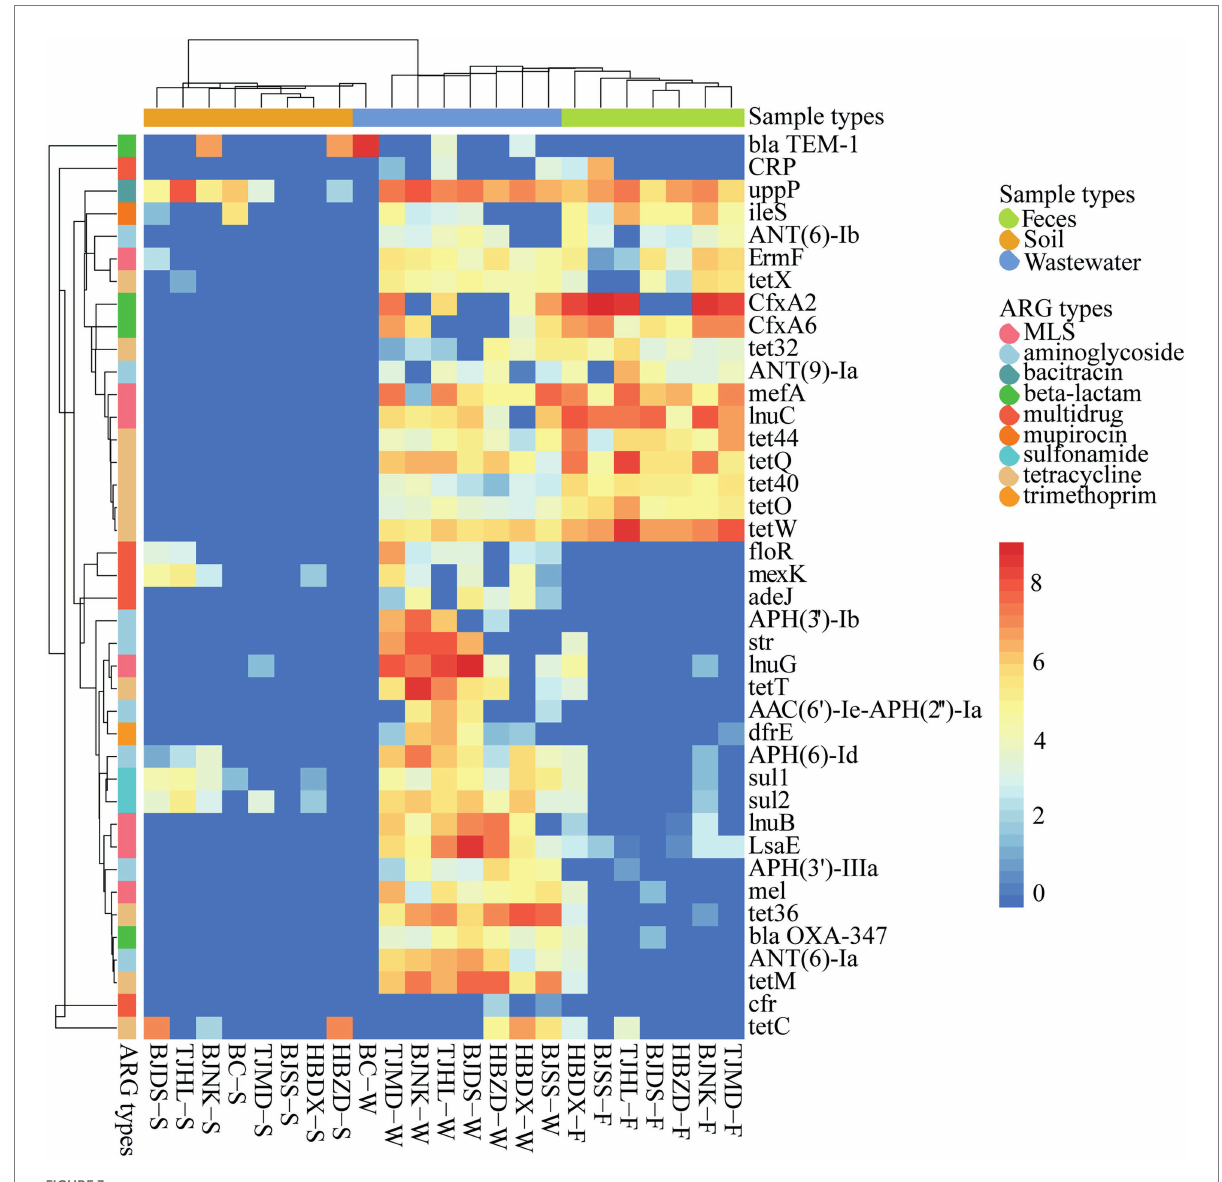
FIGURE 3 Heatmap of main ARG subtypes (coverage, × /Gb, log2 transferred) in 23 environmental samples. The combination of four letters (e.g., TJHL) represents a farm; BC, blank control; W, wastewater; F, feces; S,